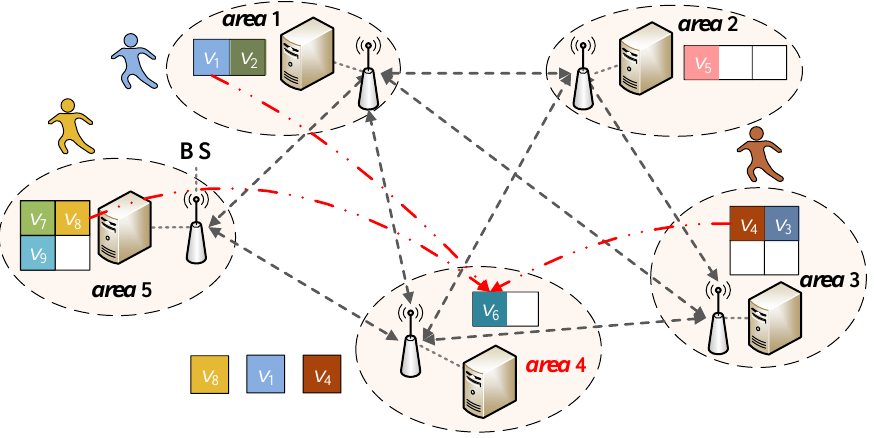
Figure 3. Services actions with migration